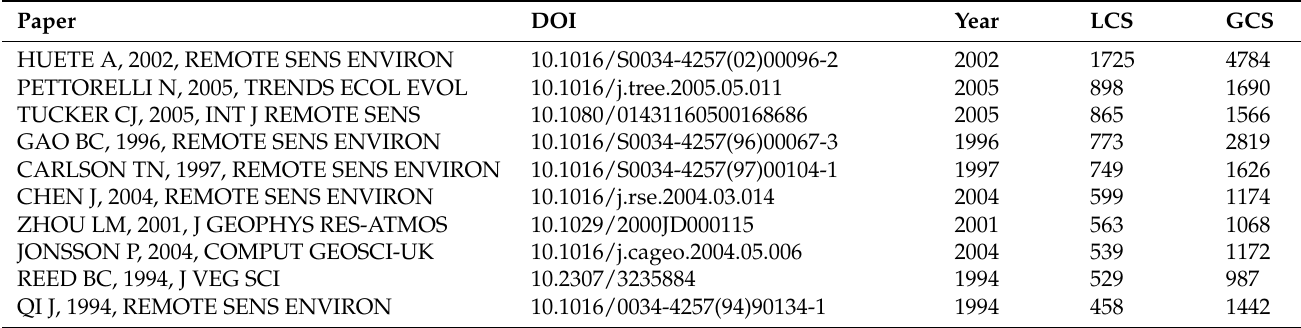
Table 6. Top ten papers according to the local citation score.